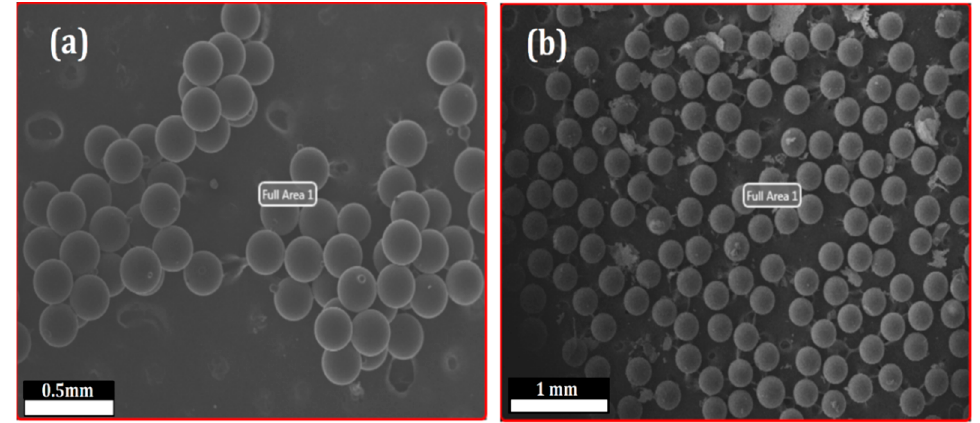
Figure 5. SEM micrographs of ( a ) Dowex resin beads and ( b ) CR-AgNCs.